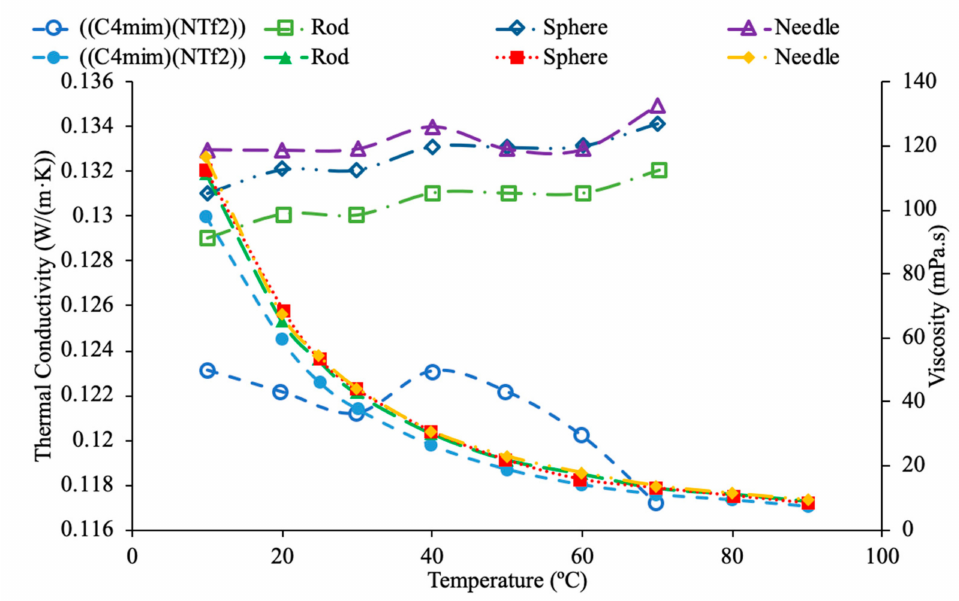
Figure 27. Thermal conductivity (increasing with temperature) and viscosity (decreasing with temperature) for 1-Butyl-3-methylimidazolium bis(trifluoromethylsulfonyl) imide ((C4mim) (NTf2)) based nanofluid with Al 2 O 3 particles that are 2–5 nm diameter and 70–100 nm length needles, 10 nm diameter and 100 nm length rods, and 10 nm diameter spheres at 1 wt %